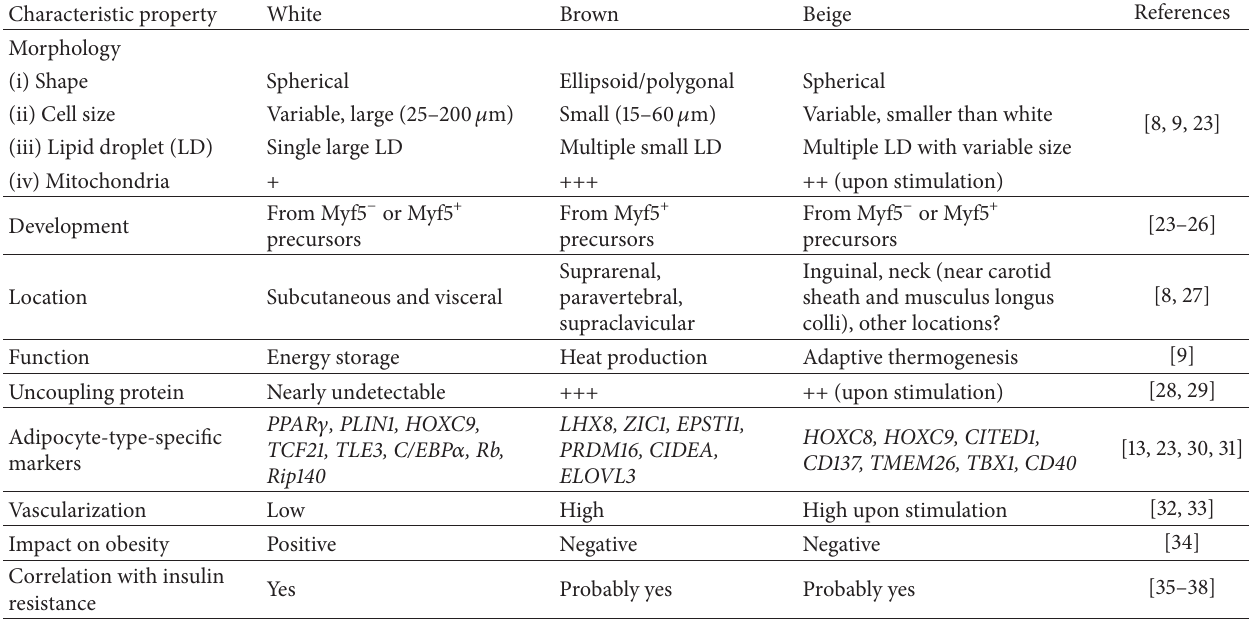
Table 1: Main differences amongst the three types of adipocyte